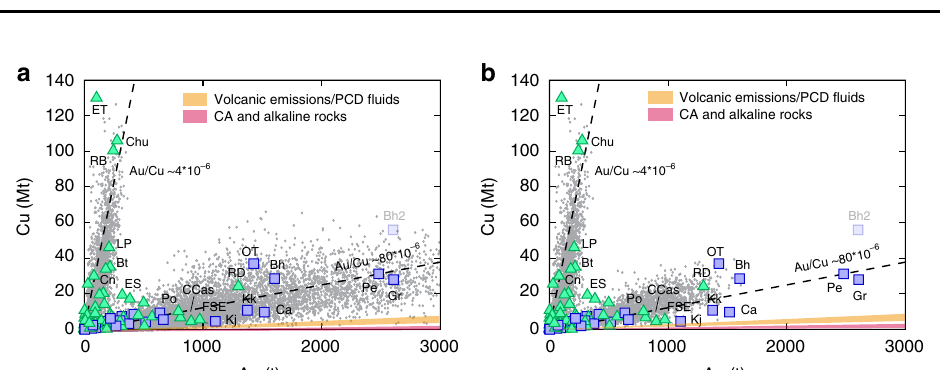
Fig. 4 Monte Carlo simulations (light grey dots; N > 20,000) for the trends of Cu-rich and Au-rich porphyry deposits. a Simulations carried out for Au precipitation ef fi ciencies that are approximately fi ve times higher for the alkaline systems-related Au-rich trend than for the calc-alkaline systems-related Cu-rich trend (see text, Methods, and Table 1); b simulations carried out for Au precipitation ef fi ciencies that are ~12 times higher for the calc-alkaline systems-related Au-rich trend than for the calc-alkaline systems-related Cu-rich trend (see text, Methods, and Table 1). Also shown are the Au/Cu ratios for volcanic emissions and single-phase fl uids of porphyry deposits (orange fi eld: Table 2) and of calc-alkaline and alkaline rocks (red fi eld: Table 2). Abbreviations of porphyry deposits: Bh Bingham, Bt Butte, Ca Cadia, CCas Cerro Casale, Chu Chuquicamata, Cn Cananea, ET El Teniente, FSE Far Southeast-Lepanto, Gr Grasberg, Kj Kadjaran, Kk Kalmakyr, LP Los Pelambres, OT Oyu Tolgoi, Pe Pebble, Po Potrerillos, RB Rio Blanco, RD Reko Diq. Bingham has two points (Bh and Bh2) due to different tonnages reported in different studies (see Supplementary Data